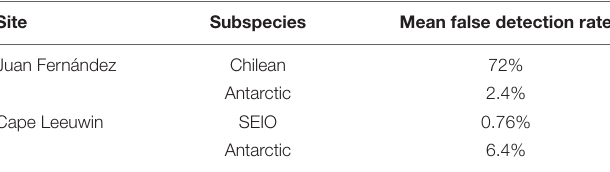
TABLE 1 | Mean false detection rates for the blue whale subspecies at Juan Fernández and Cape Leeuwin. Site